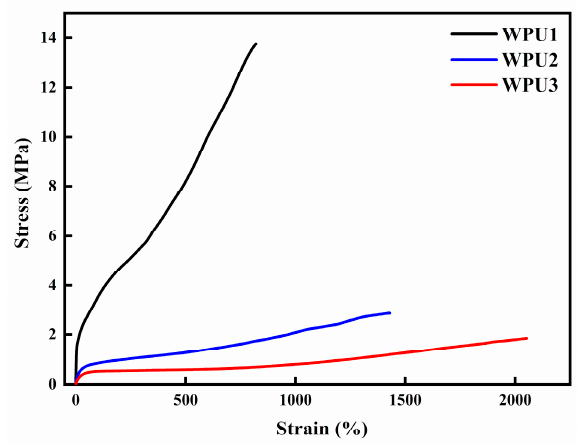
Figure 6. Stress-strain curve of WPU1, WPU2, WPU3.